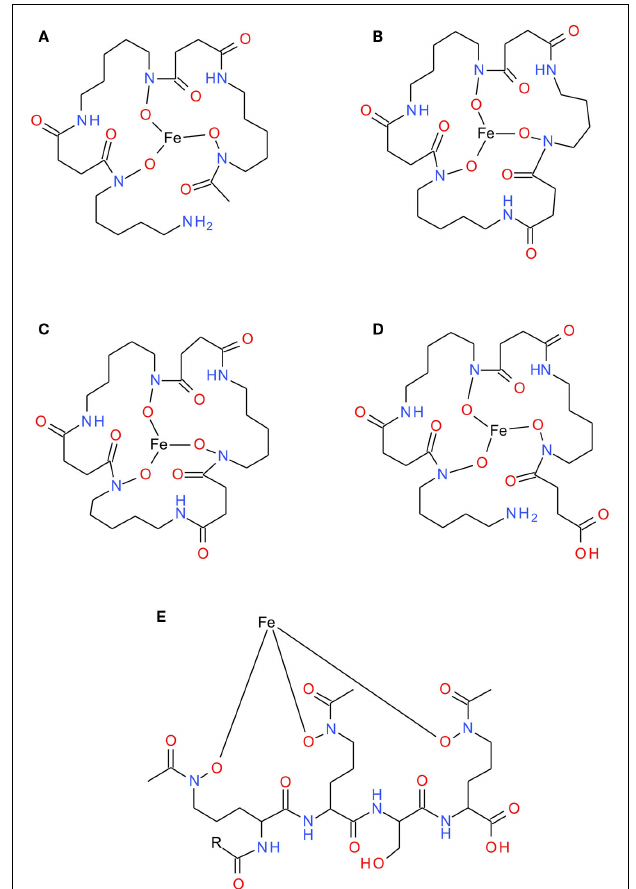
FIGURE 3 | Structures of fully characterized siderophores that have been identified in seawater or natural seawater incubations.